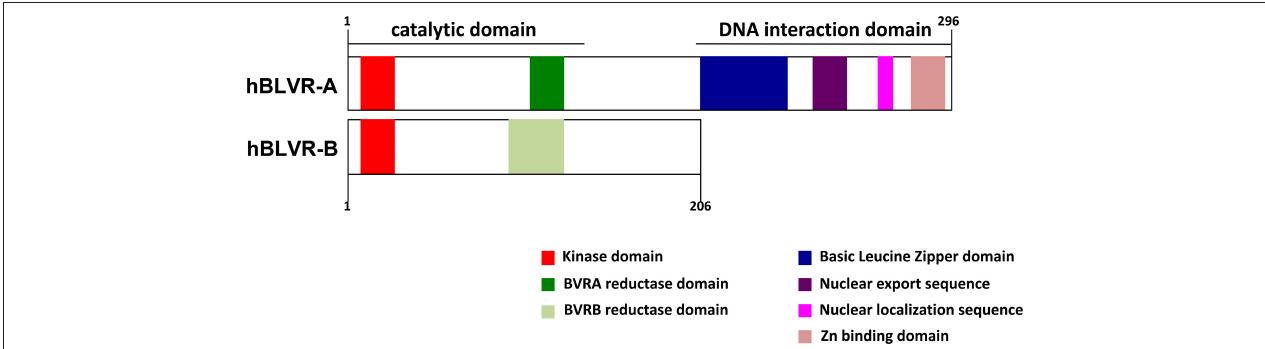
FIGURE 2 | Domain structures of human BLVR-A and BLVR-B. A schematic comparison of the structure of human BLVR-A and BLVR-B shows a similar kinase and catalytic domain for both enzymes. The two isoforms differ in the C-terminus, where BLVR-A contains a bZip DNA binding domain, a nuclear localization sequence and a nuclear export sequence that are not present within